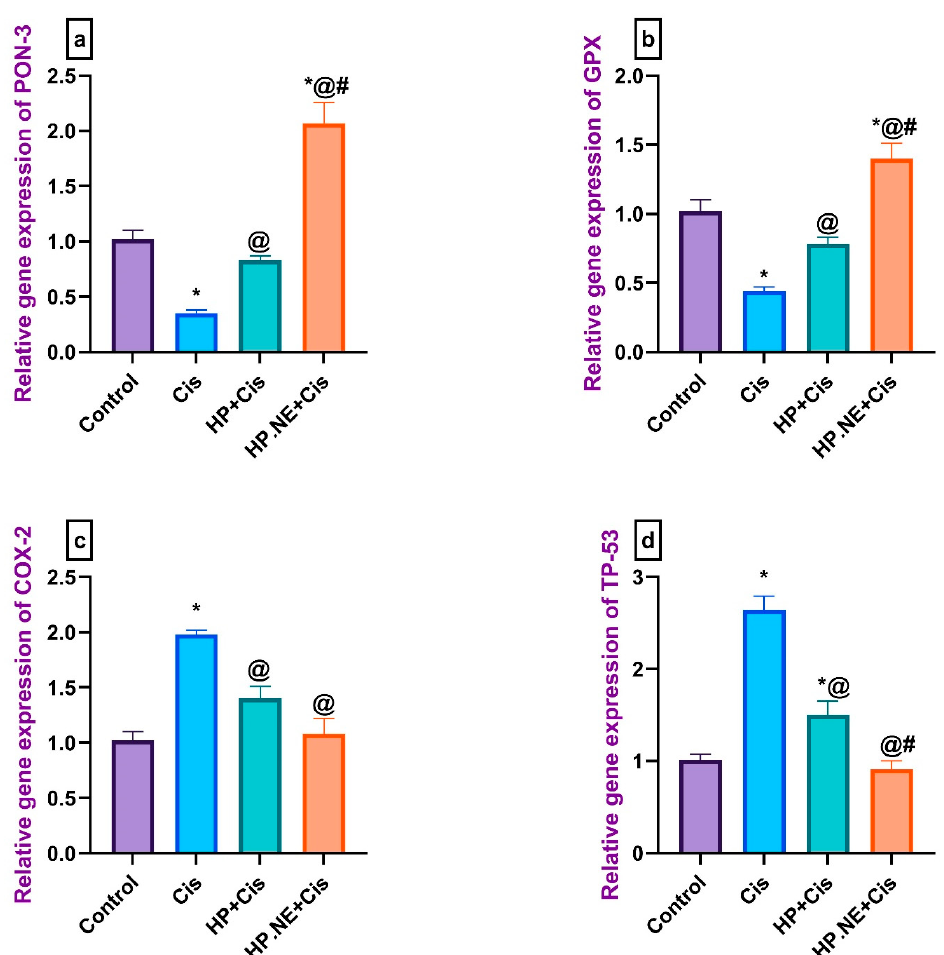
Figure 6. Effect of HP L. and HP.NE administration on the relative gene expression of PON-3, GPX COX-2, and TP-53 in brain tissues of different groups. ( a ) PON-3: paraoxonase 3, ( b ) GPX: glutathione peroxidase, ( c ) COX-2: cyclooxygenase-2, and ( d ) TP-53: tumor protein p53. Data are expressed as mean ± SE (one-way ANOVA) followed by Tukey’s post hoc test for seven rats in each group. * means significant from the Control group; @, significant from the Cis group; #, significant from the HP + Cis group.